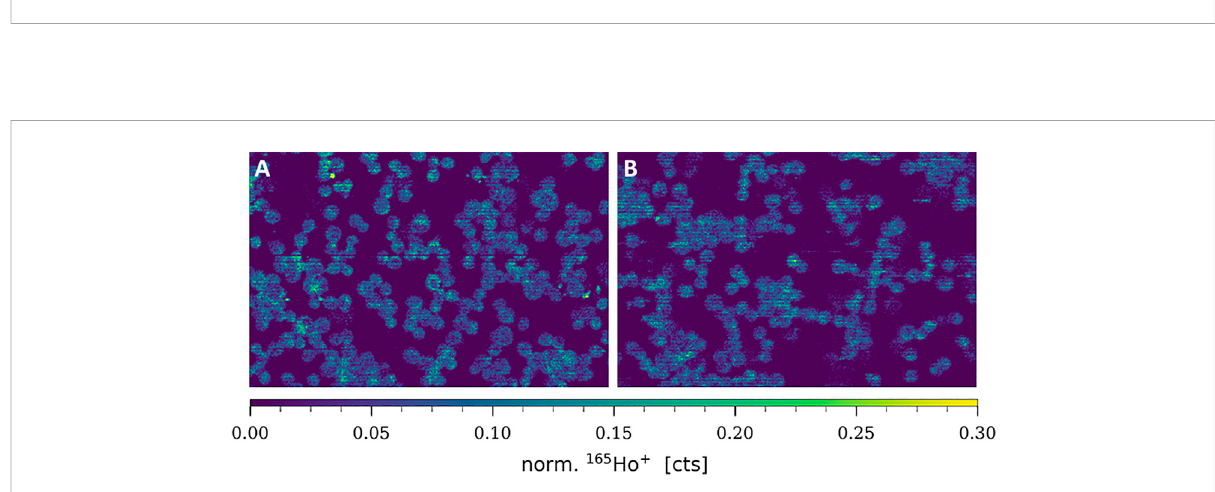
FIGURE 3 Signal intensity maps of 165 Ho + , showing normalized cellular levels of plasma membrane-bound CTR1 in (A) A2780 and (B) A2780cis. Cytospin samples were measured by LA-ICP-TOFMS imaging at the single-cell